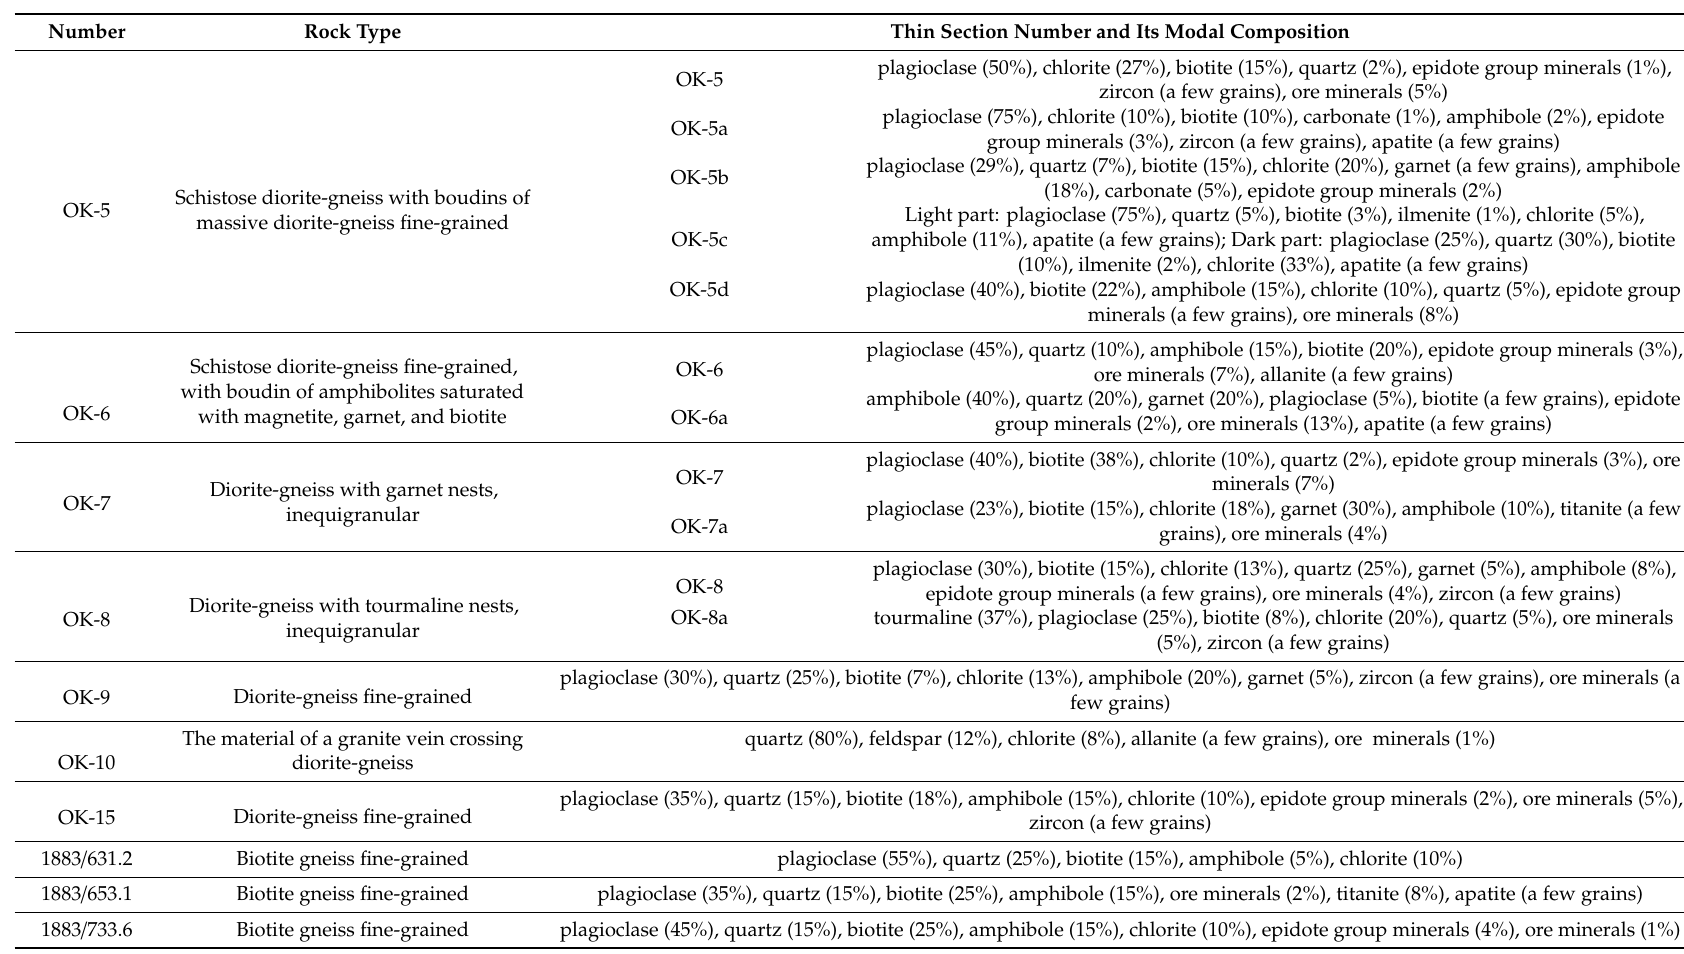
Table 1. Mineral composition of the studied rocks from the diorite window (DW) block and borehole